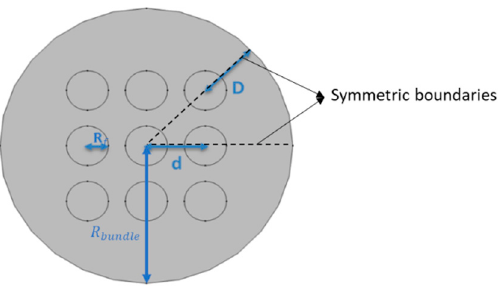
Figure 6. Solution domain nomenclature for the circular bundle and symmetric boundaries.